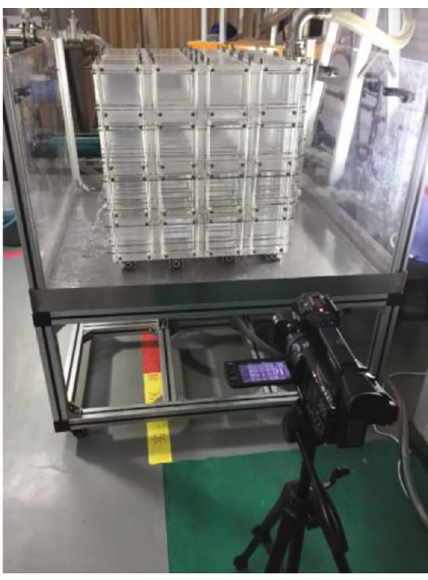
Figure 8: Highspeed video camera record proppant transport characteristics in complex